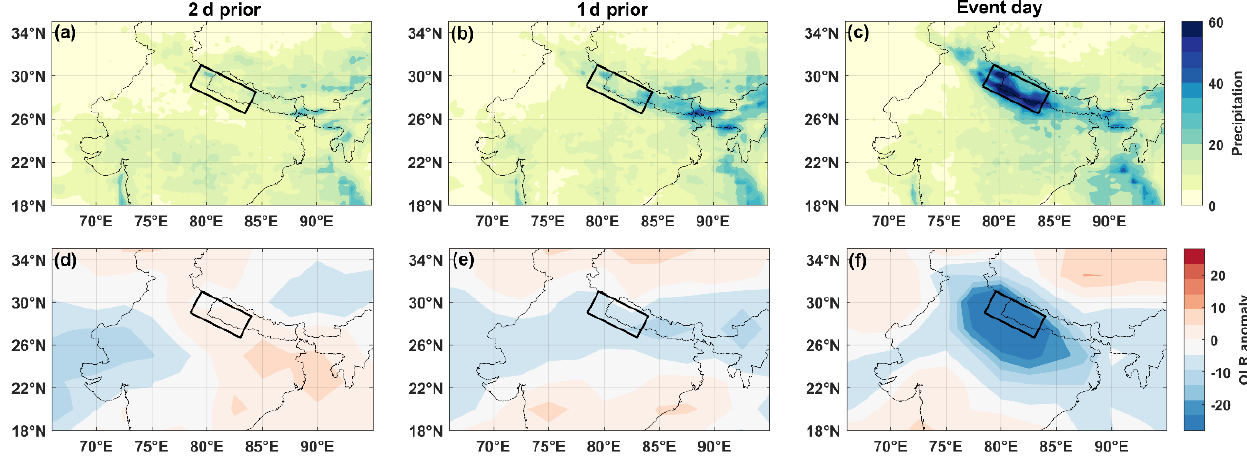
Figure 4. Composites of daily accumulated precipitation (a–c) in mmd − 1 and OLR (d–f) in Wm − 2 for the event day (c, f) and 1d prior (b, e) and 2d prior to the event (a, d) .